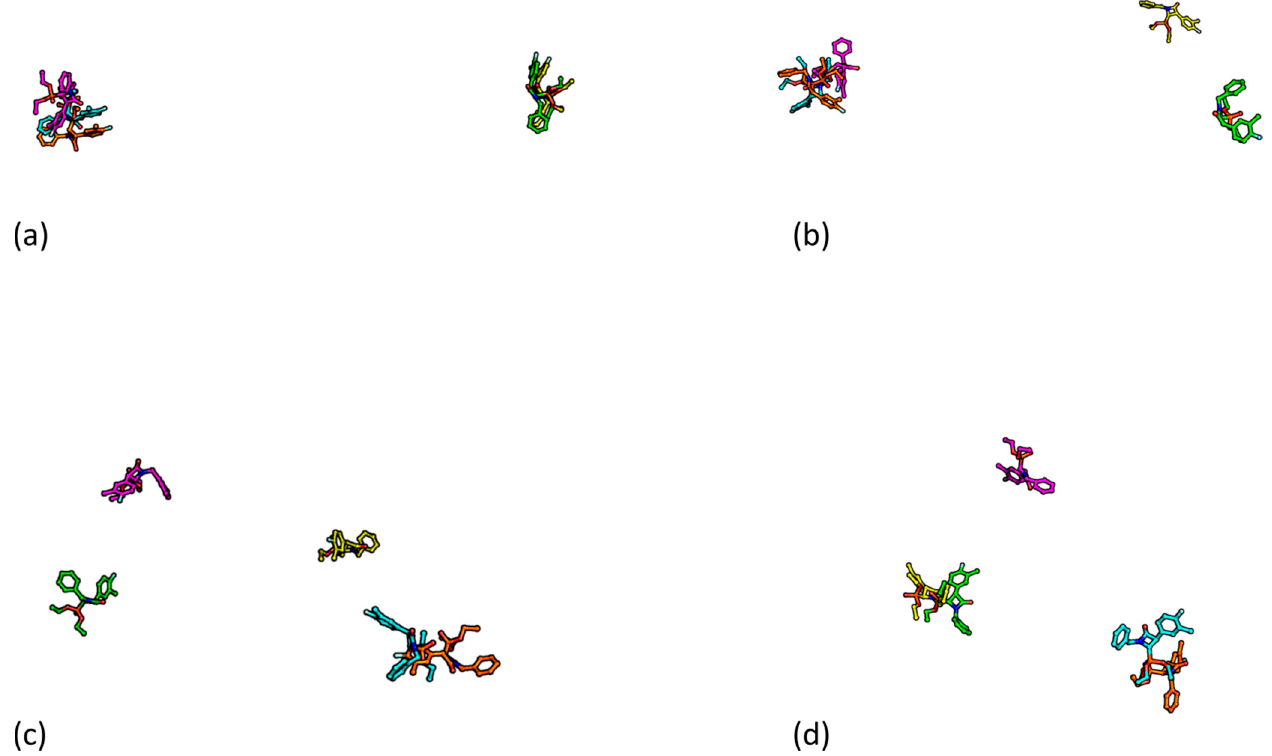
Figure 9. Docking selected frames from MD simulations for ( a ) (3 R ,4 R )- 11f , ( b ) 3 S ,4 S )- 11f , ( c ) (3 S ,4 R )- 11f , ( d ) (3 R ,4 S )- 11f with PBP2a; frame 1–green, 250–yellow, 500–magenta, 750–cyan, 1000–orange.